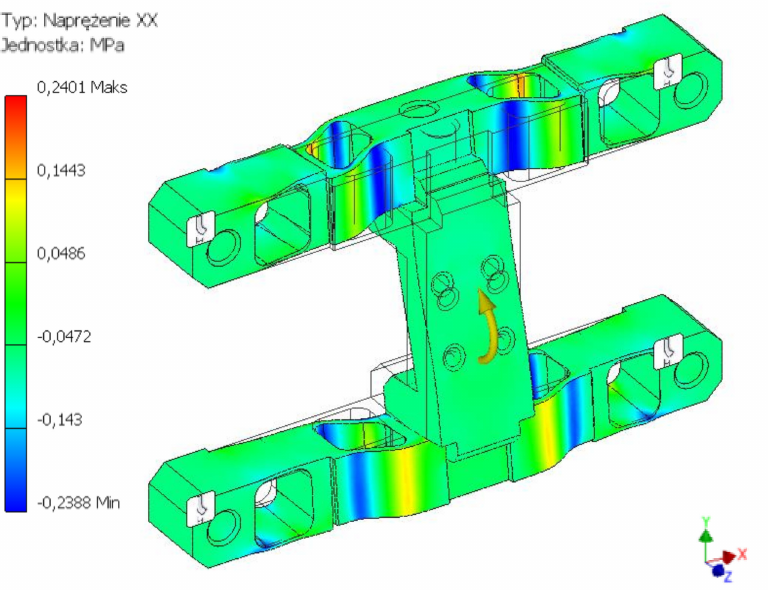
Figure 8. H-M-H strain map for the force value of 150 N acting along the X